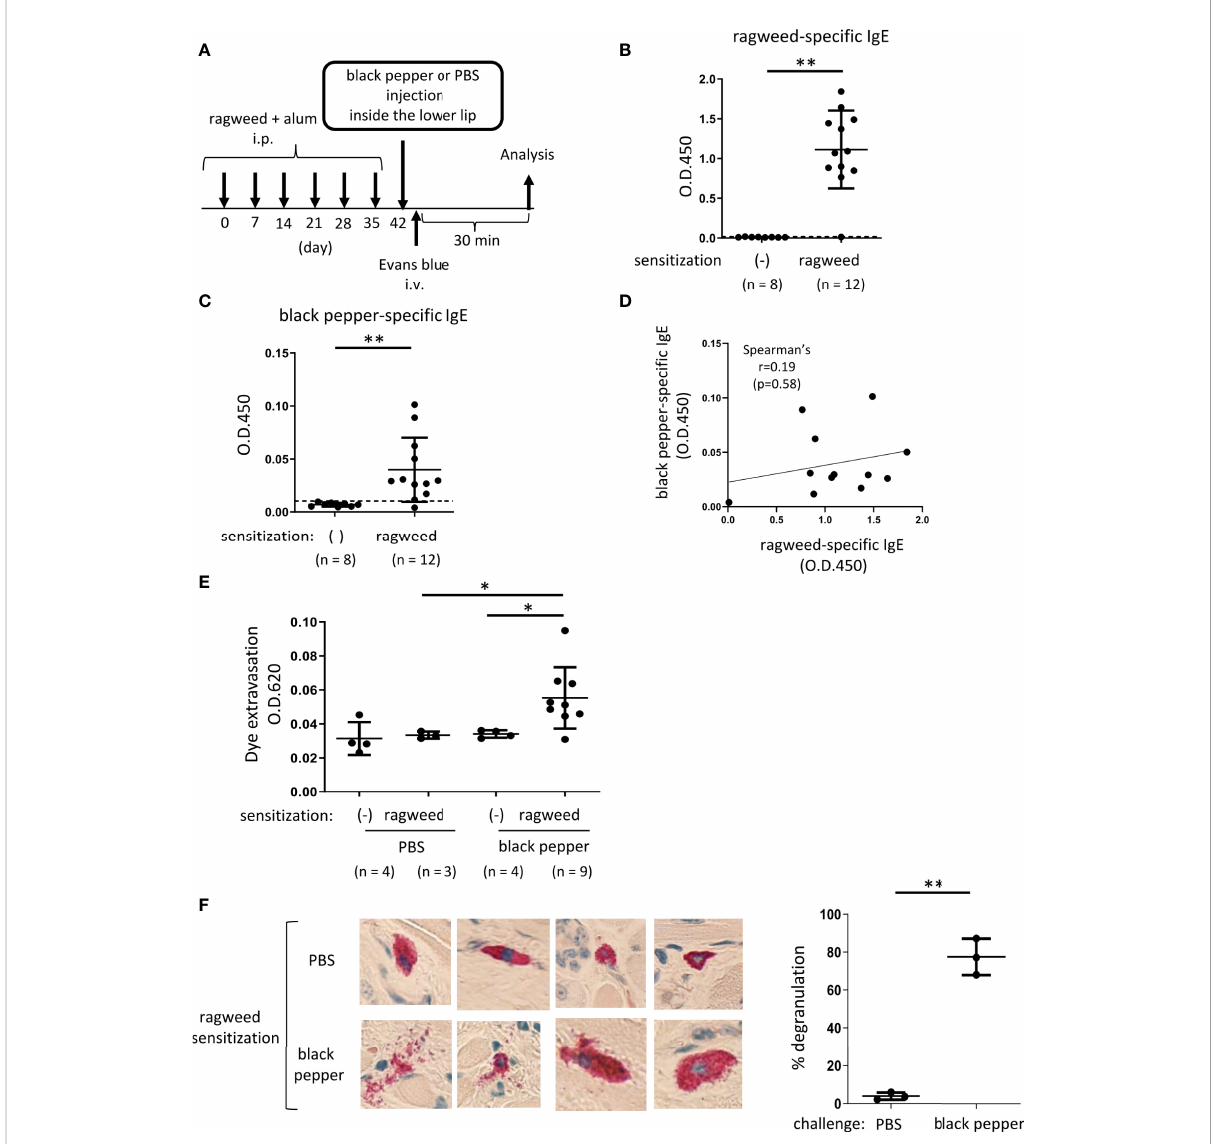
FIGURE 4 Ragweed pollen cross-reacts with black pepper in murine model of OAS. (A) A schematic representation of murine model of OAS. WT mice intraperitoneally sensitized with ragweed pollen before stimulation with black pepper or PBS as a control. (B-D) Serum levels of ragweed- speci fi c (B) and black pepper-speci fi c IgE (C) from ragweed-sensitized mice at day 42 (n = 12) or non-sensitized control mice (n = 8). (B and C) A positivity threshold (mean + 2SD in non-sensitized mice) is shown as a dotted line. Data are presented as mean ± SD. Data are representative of two independent experiments. Welch ’ s t -test. ** P < 0.01. (D) No correlation between serum levels of ragweed-speci fi c IgE and black pepper- speci fi c IgE from ragweed-sensitized mice (n =12). Spearman ’ s correlation test. (E) Quanti fi cation of the Evans blue dye that extravasated into the neck skin from ragweed-sensitized mice stimulated by black pepper extract (n = 9) or PBS (n = 3) or from non-sensitized control mice stimulated by black pepper extract (n = 4) or PBS (n = 4). Data are presented as mean ± standard deviation. Data are representative of two independent experiments. Brown-Forsythe and Welch ANOVA with Dunnett T3 multiple comparisons. * P < 0.05. (F) Representative images of chloroacetate esterase-stained mast cells in tissue sections in the inside of the lower lip from ragweed-sensitized mice stimulated by black pepper extract (left/lower panel) or PBS (left/upper panel). Percentages of degranulated mast cells were shown (right). n = 3 per each group. Data are presented as mean ± SD. Data are representative of two independent experiments. Welch ’ s t -test. ** P <